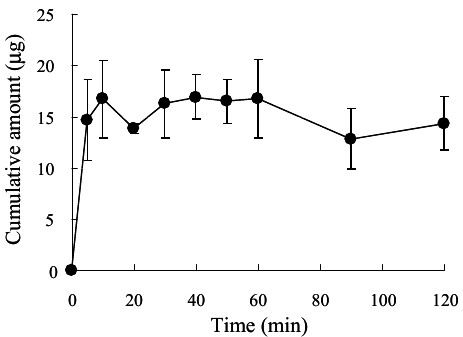
Figure 2. The release profile of ALN from ALN(TIP)–MN in phosphate buffered saline (PBS). Results are expressed as the mean ± S.E. of three experiments.